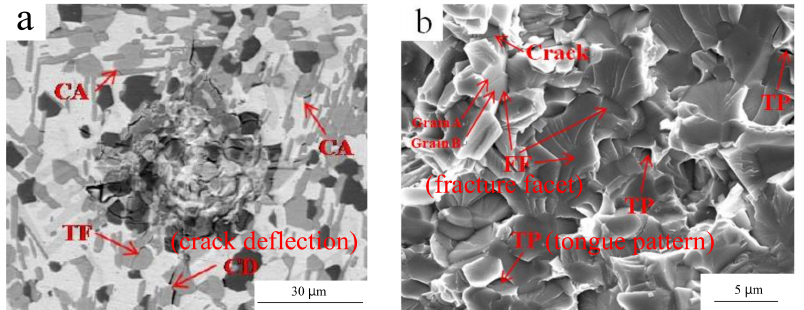
Figure 8. Vickers hardness indentation and fracture morphology of composites: ( a ) Vickers hardness indentation; ( b ) fracture